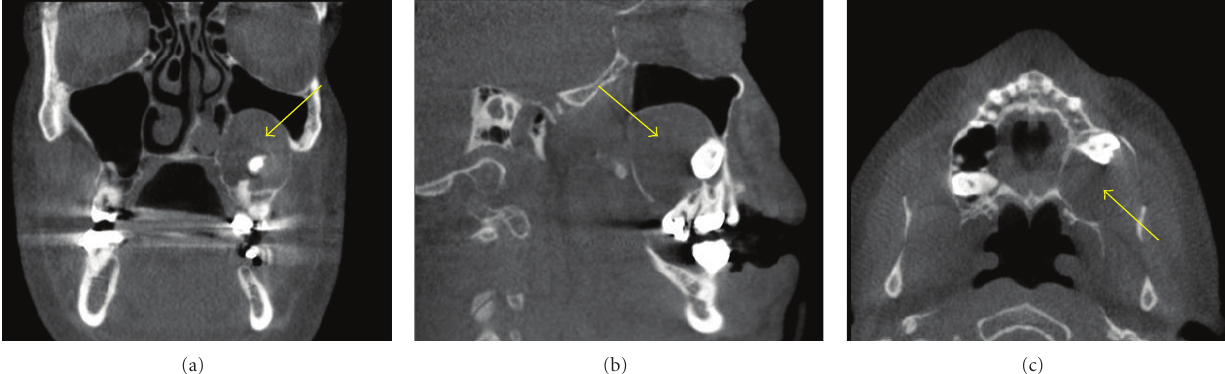
Figure 4: A dentigerous cyst (arrows) seen as well defined radiolucent entity around the crown of the impacted and displaced maxillary left third molar and is encroaching into the left maxillary sinus in these MPR images.